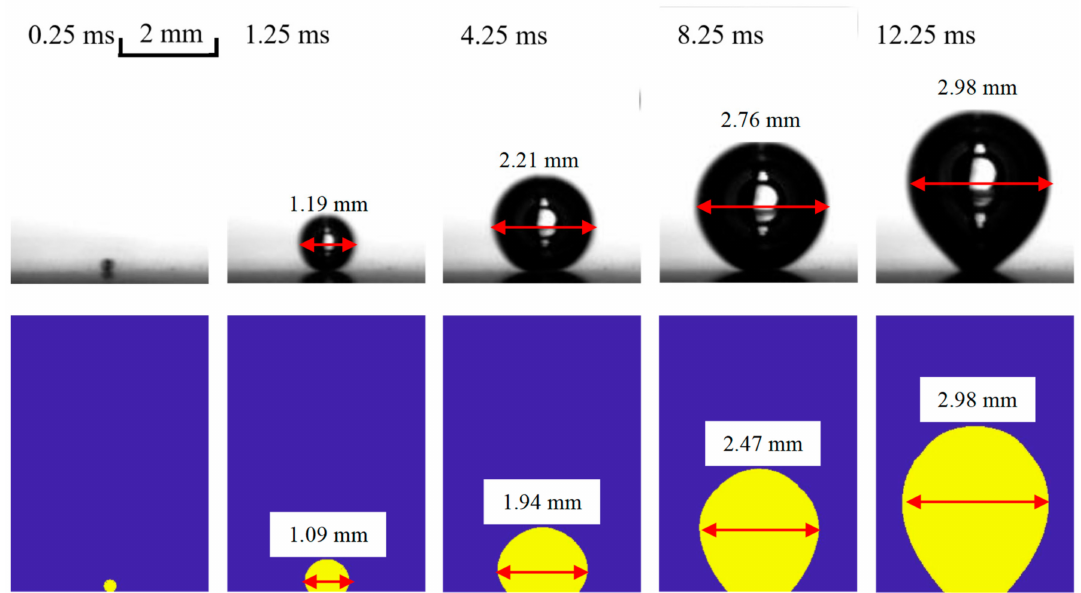
Figure 10. Pool boiling bubble on bared ITO heater at ∆ T w = 7.22 ◦ C: HSV snapshots (upper) and present simulation